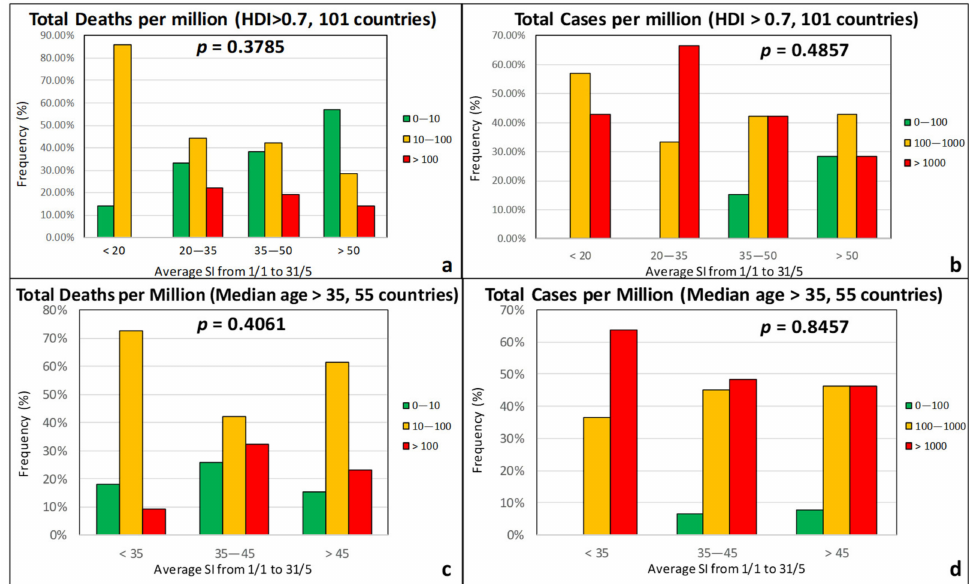
Figure 13. Frequency of total deaths per million (green: low, 0–10; orange: moderate, 10–100; red: high, > 100) and total cases per million (green: low, 0–100; orange: moderate, 100–1000; red: high, > 1000) as a function of the average Stringency Index for countries with an HDI over 0.7 ( a , b ) and a median age over 35 years ( c , d